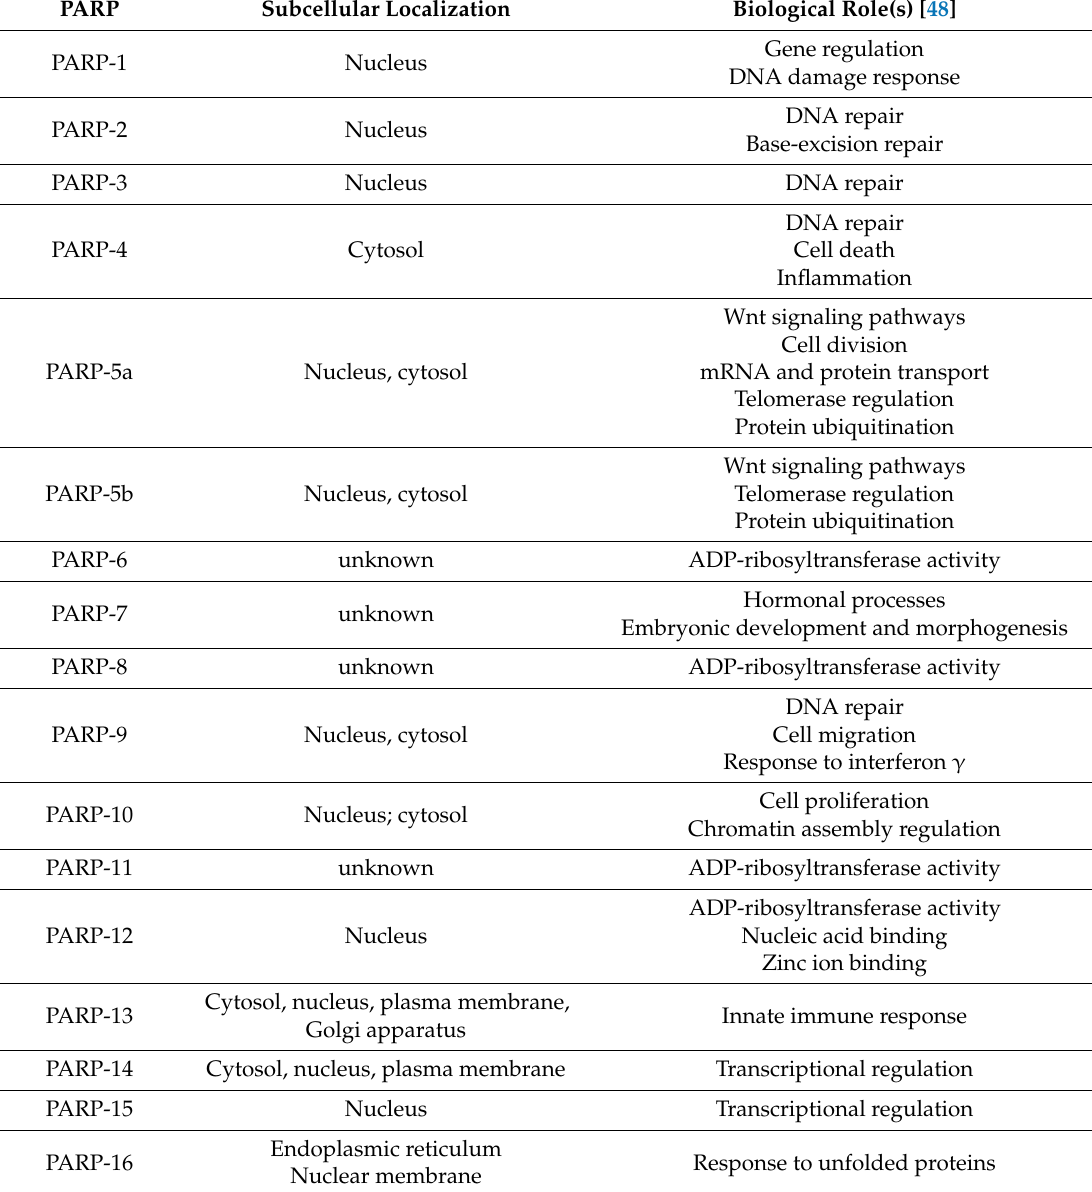
Table 1. Main biological functions fulfilled by the PARP-family